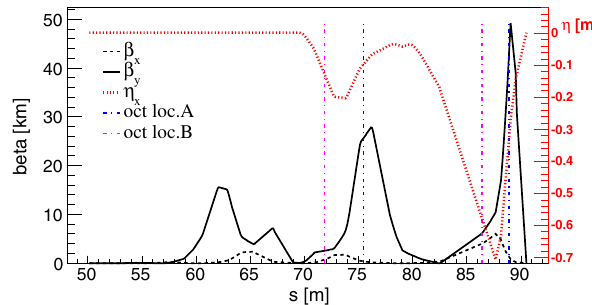
FIG. 6. β functions and dispersion along the FF line with the two octupoles locations under consideration.